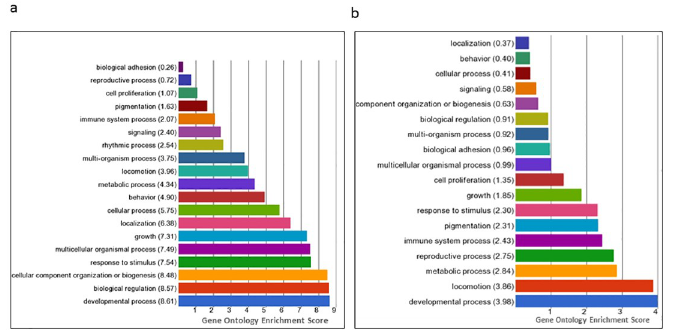
Fig 3. Bar chart of GO enrichment scores for DEGs according to biological processes in male/female Cln3 Δ ex7/8 mouse brain. Gene expression in GalCer- versus vehicle-treated male (a) and female (b) Cln3 Δ ex7/8 mouse brain. Differential expression is assumed with a p-value < 0.05, and a gene count > 2 of the DEGs. Functional categories of DEGs were obtained using GO annotations from the Partek Genomics Suite classification system.